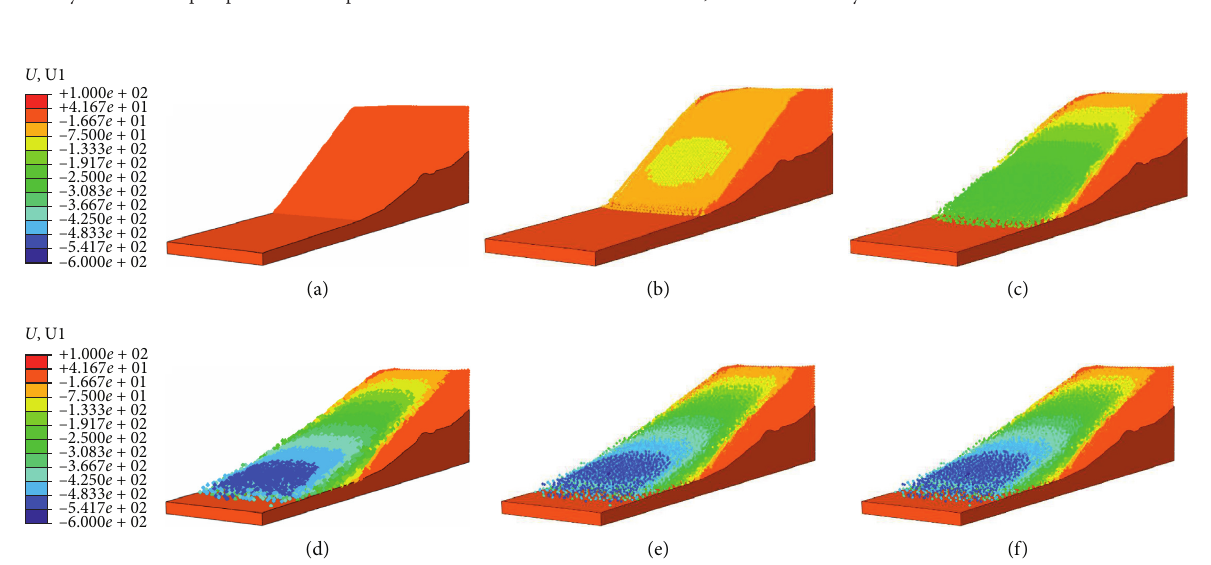
Figure 11: The displacement (U1) and shapes of the landslides at different times. (a) t � 0 s. (b) t � 8 s. (c) t � 17 s. (d) t � 30 s. (e) t � 40 s. (f) t � 100